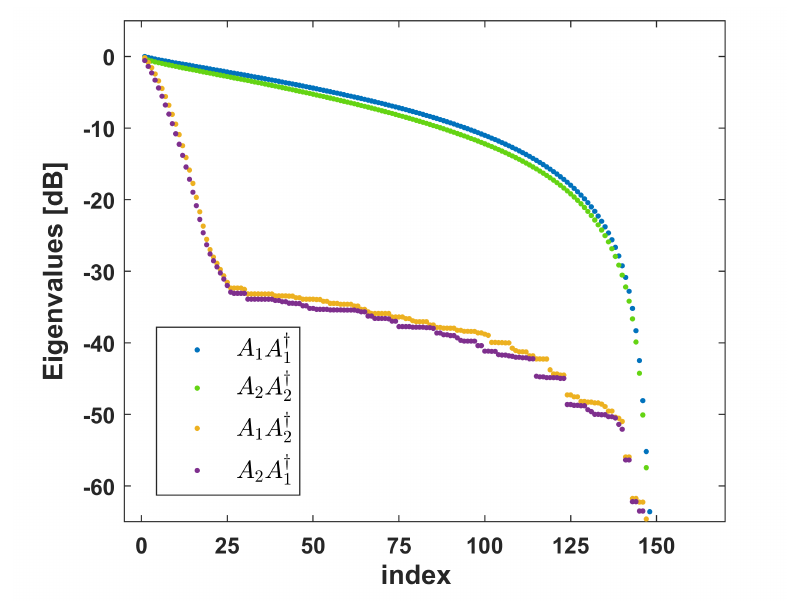
Figure 10. Eigenvalues of the operators A 1 A †